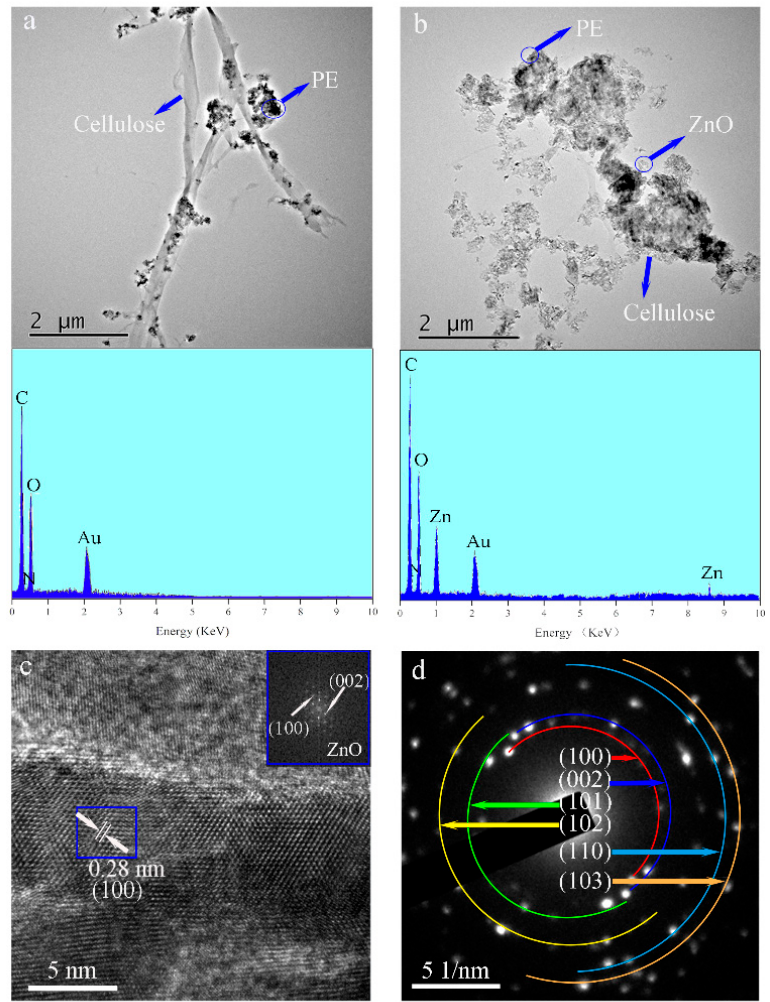
Figure 2. TEM images and EDS mapping of the PE/wood fiber-composite ( a ), and of the PE/ZnO/wood-fiber composite ( b ); ( c ) HRTEM image of the PZW composite, and SAED image corresponding to the area in the blue rectangle (inset); ( d ) SAED pattern of the PZW composite.